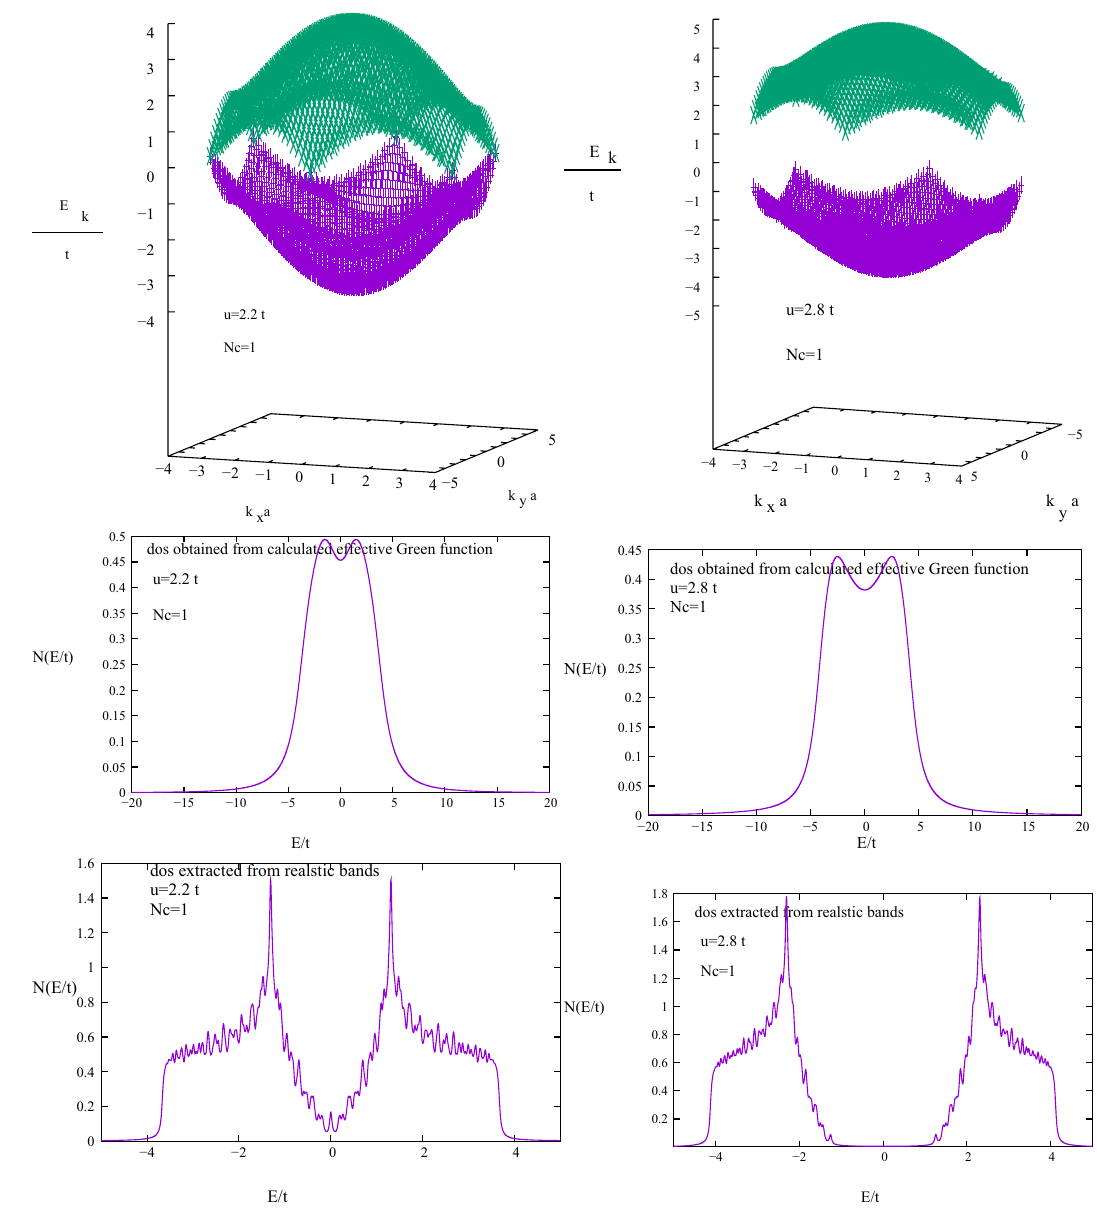
2.2 t and 2.8 t =